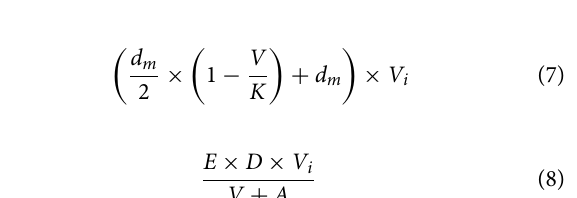
zero when it reaches the maximal number of days in a year. Continuous transitions are used to simulate the various pieces of the piecewise linear functions describing the mortality and biting rates. All labels at arcs or places are constants; compare caption of Figure 4